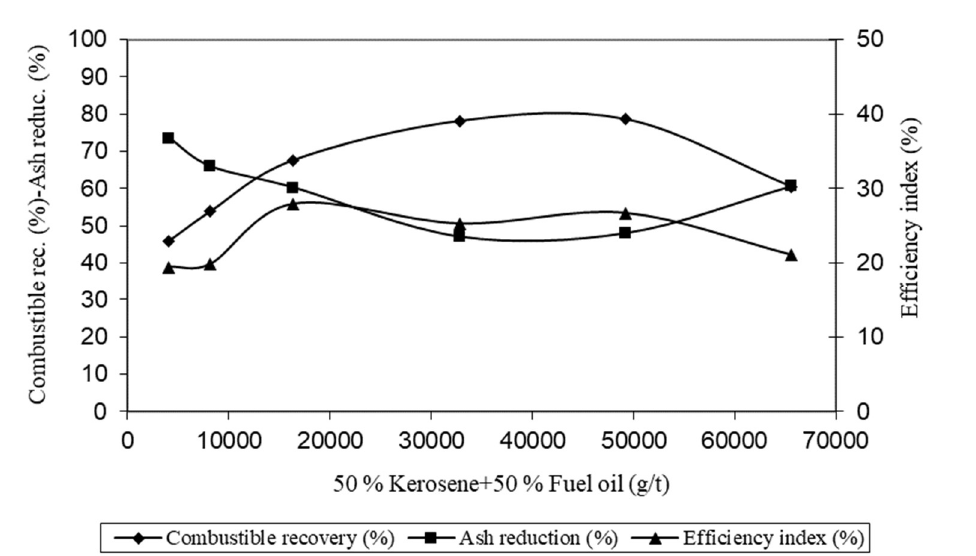
Fig.6 . Effect of 50% kerosene + 50% fuel oil concentration on combustible recovery, ash reduction and efficiency index